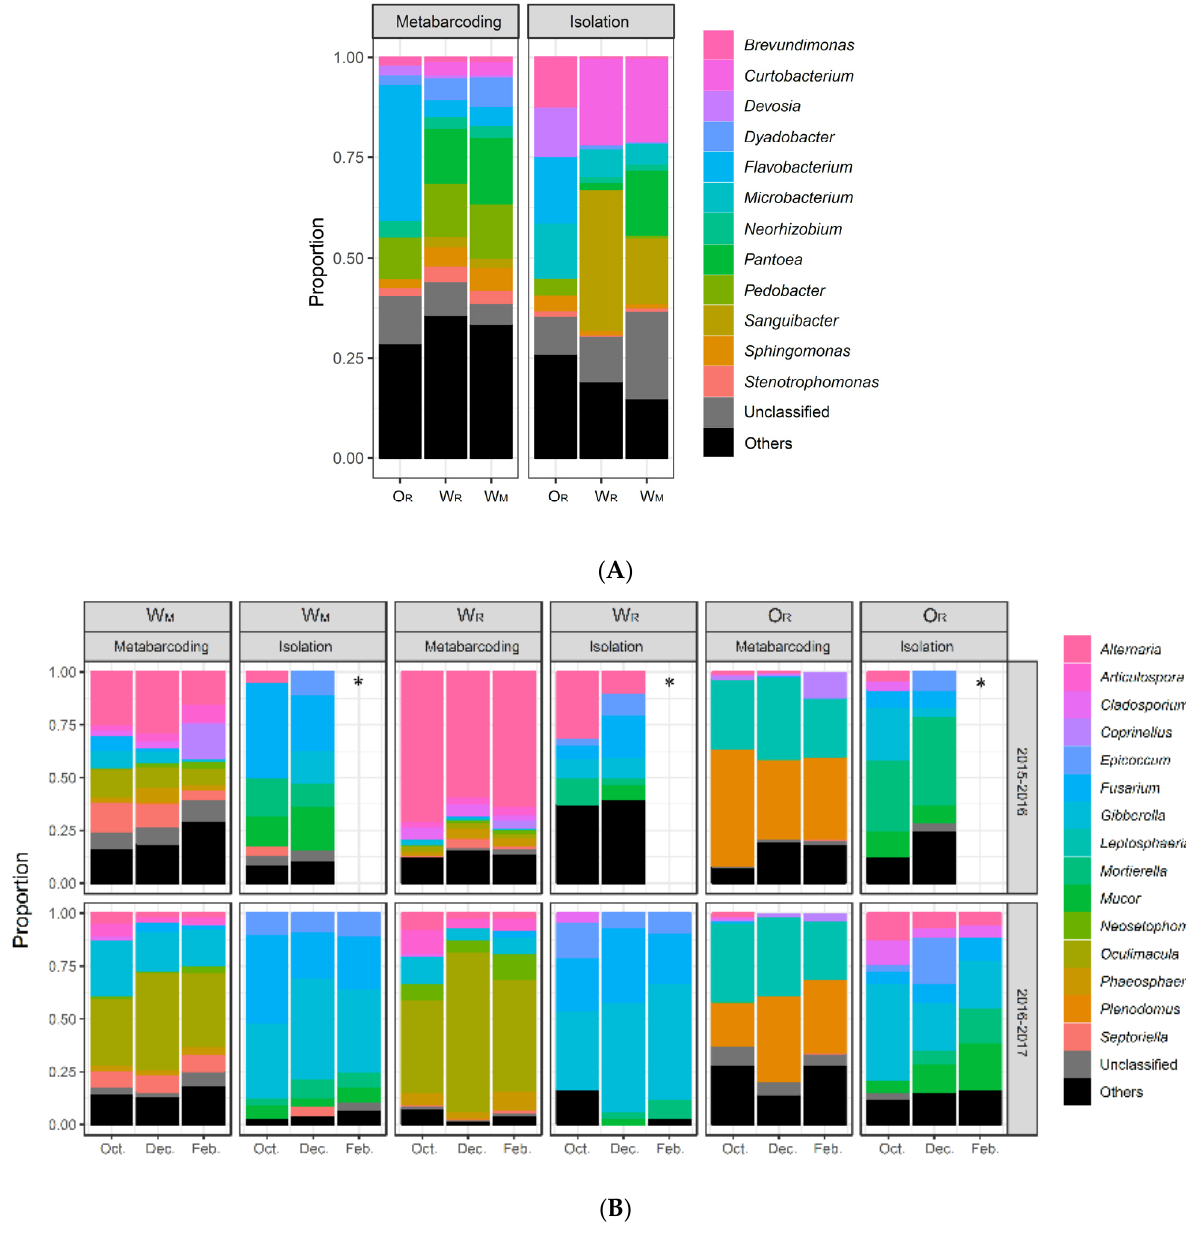
Figure 4. Profiles of the residue-associated bacterial and fungal communities obtained by metabarcode sequencing (‘metabarcoding’) and by culture-dependent molecular identification (‘isolation’). ( A ) For the bacterial community, comparisons were based on the same 3 × 5 wheat (W) and oilseed rape (O) residue samples collected from the wheat monoculture plot (W M ) and the two wheat–oilseed rape rotation plots (W R and O R ) in October 2015. ( B ) For the fungal community, comparisons were based on the same 90 × 12 wheat (W) and oilseed rape (O) residue samples collected from the wheat monoculture plot (W M ) and the two wheat–oilseed rape rotation plots (W R and O R ) during three sampling periods (October, December, and February) in the 2015–2016 and 2016–2017 cropping seasons. Only the 12 most abundant bacterial genera and the 16 most abundant fungal genera are presented. The composition of the three sets marked by * is missing due to unsuccessful isolation.